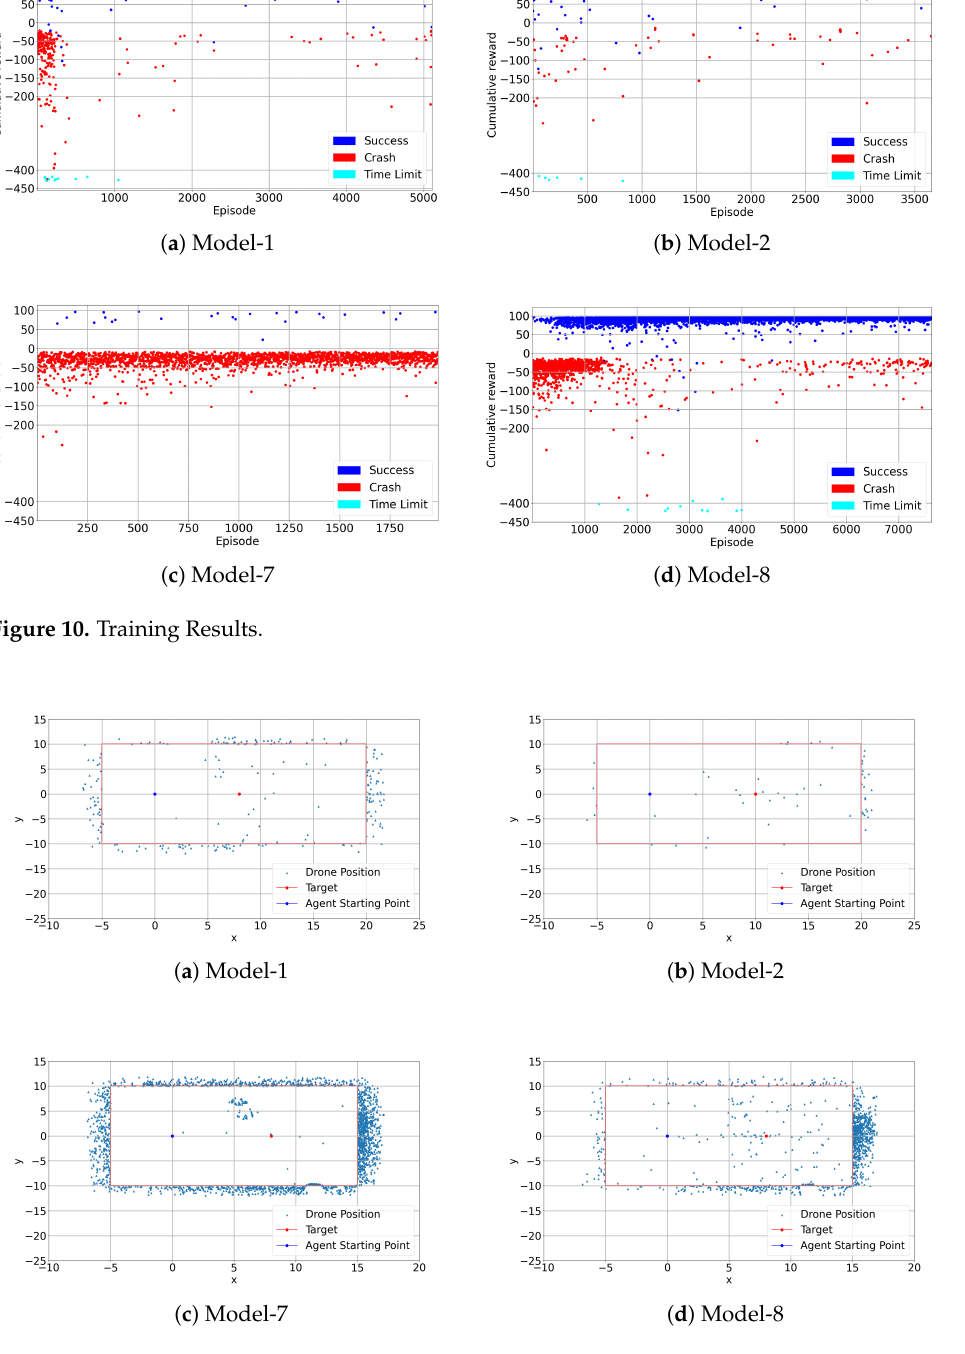
Figure 11. Crash